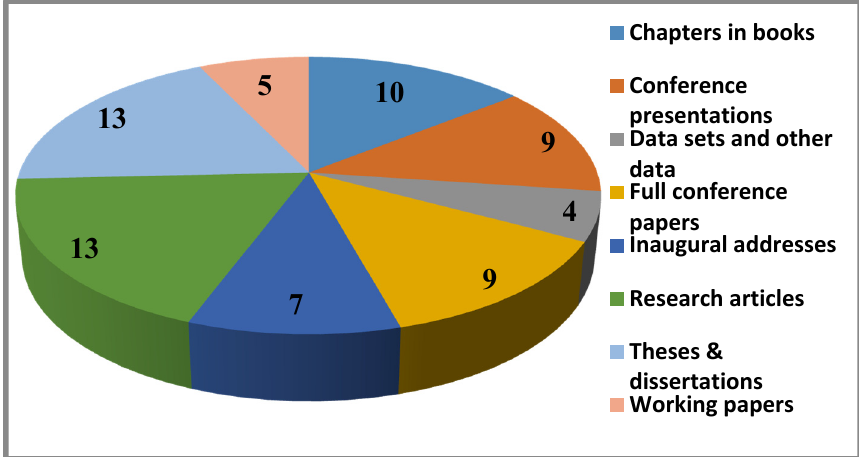
Figure 3. Type of content in IRs (N = 23)